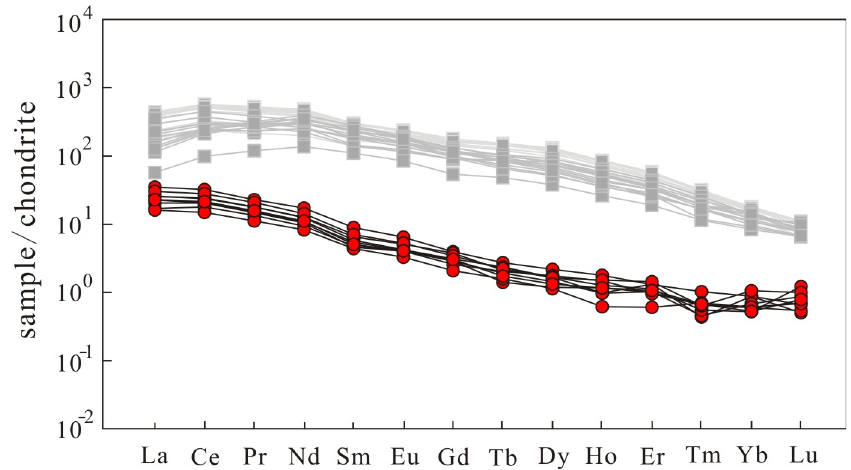
Figure 7. Chondrite-normalized REE patterns for dolomite mineral grains from the Dol-dyke. The gray lines are data of coarse-grained dolomite from the Bayan Obo deposit [26]. Data for normalization according to [39].